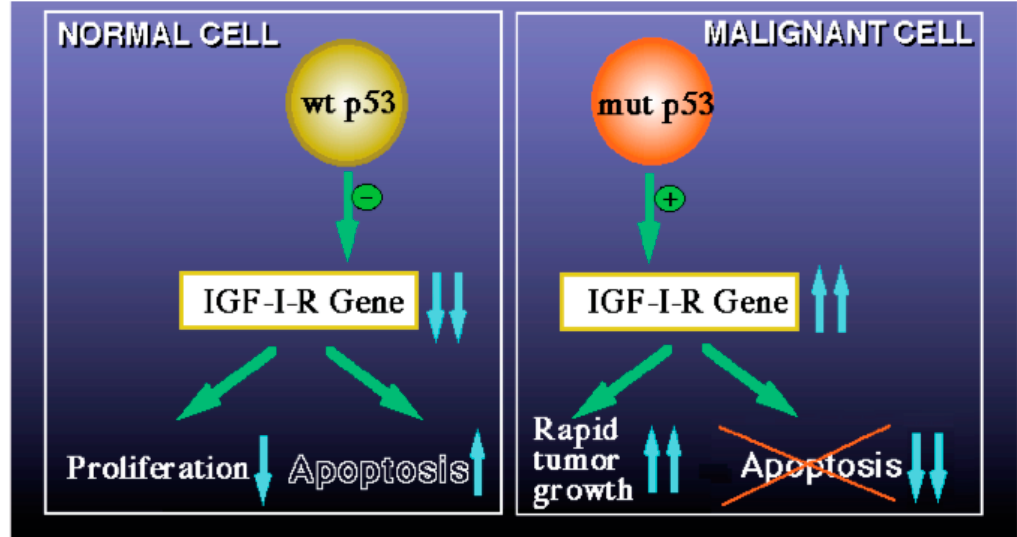
Figure 6. Schematic diagram of the regulation of IGF1R gene expression by wild-type and mutant p53. The mechanism of action of wild-type p53 involves transcriptional suppression of the IGF1R gene ( left panel ). Reduced IGF1R levels favor a post-mitotic, terminally-differentiated phenotype. Mutation of the p53 gene in tumor cells disrupts its inhibitory activity, generating oncogenic molecules capable of transactivating the IGF1R gene ( right panel ). The abundance and activity of p53 itself is regulated by IGF1, which induces p53 degradation in an Mdm2-dependent fashion.